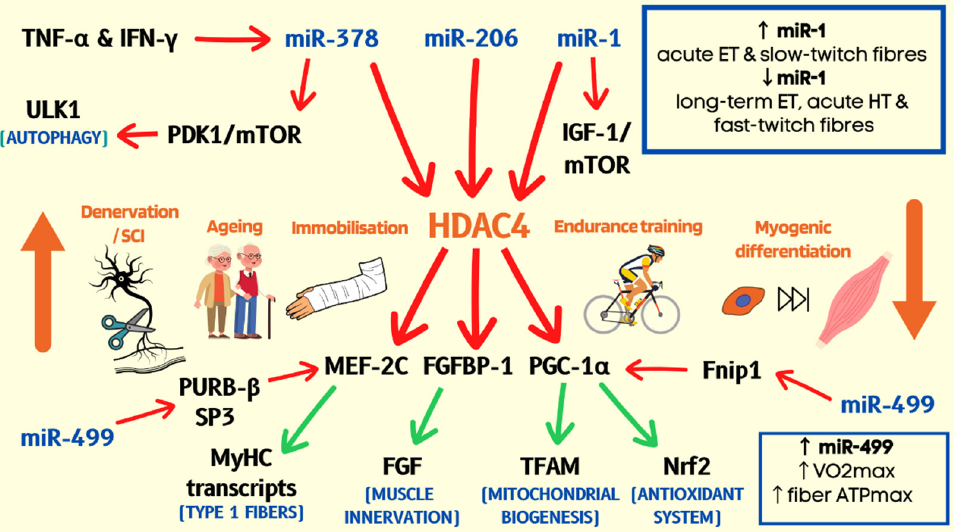
Figure 1. Muscle miRNAs regulate muscle oxidative/slow twitch phenotype and mass. HDAC4 is upregulated in pro-atrophic conditions [58–60], inhibiting the expression of MEF-2C and PGC-1 α [116,117]. This is associated with decreased transcription of muscle-contractile, mitochondrial and antioxidant proteins. HDAC4 also suppresses the expression of FGFBP-1, reducing the binding and activation of neurogenic FGFs [62]. miR-206 is upregulated following acute high-intensity exercise [47], contributing to increased muscle innervation. HDAC4 is targeted by miR-378, which promotes autophagy by releasing PDK1/mTOR-dependent suppression of autophagy-inducing ULK1 [109,112]. miR-378 levels are diminished by pro-inflammatory cytokines, TNF- α and IFN- γ [109]. HDAC4 nuclear abundance/activity decreases in response to endurance exercise [57] and in differentiating muscle progenitors [112]. miR-1 blocks HDAC4 expression and is elevated in slow-twitch relative to fast-twitch fibres. miR-1 is increased following acute endurance training (ET) compared to long-term (ET) and decreased after acute hypertrophy training [47]. Thus, ET may acutely promote miRNA profile permissive to the enhancement of oxidative phenotype while maintaining muscle protein synthesis and proliferative potential long-term. miR-499 opposes the effects of HDAC4 and strongly correlates with aerobic and metabolic capacity [121]. Red arrow—inhibition; green arrow—upregulation.